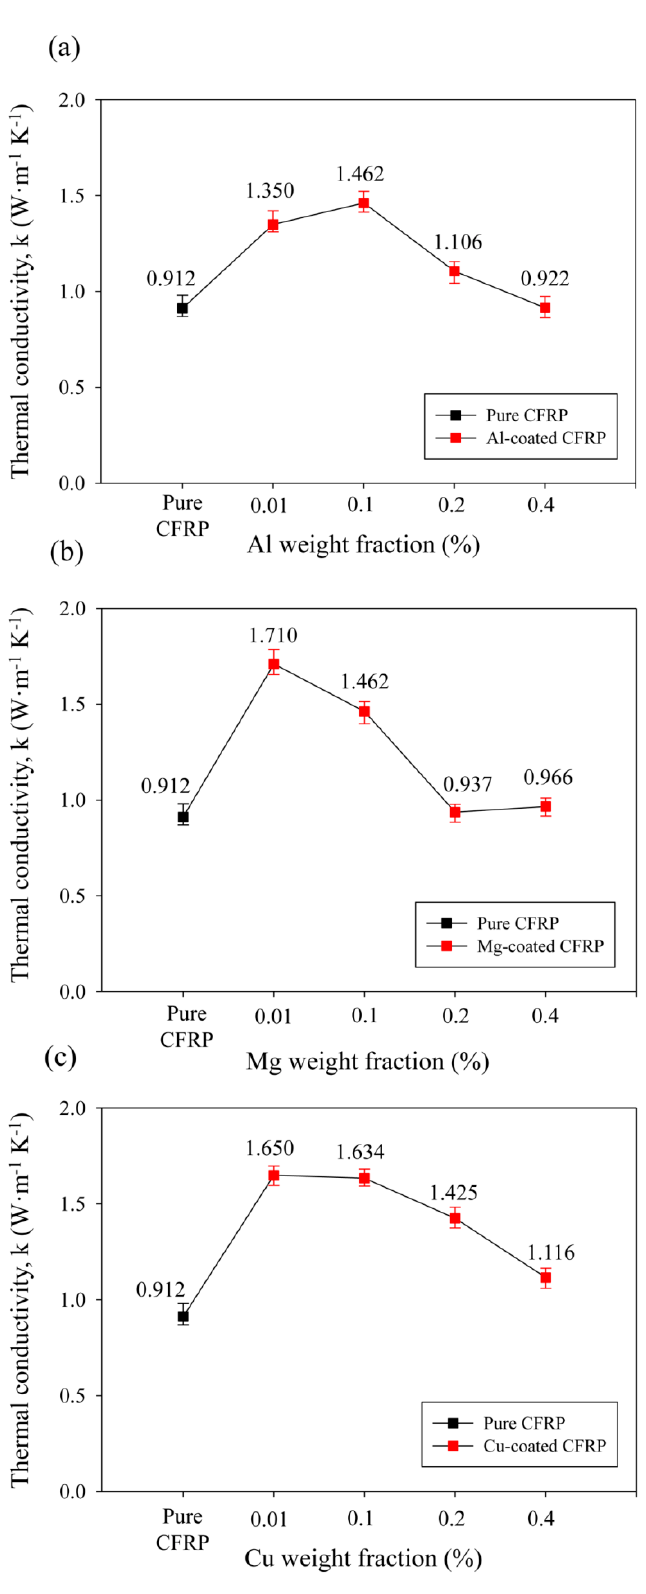
magnesium filler showed an 87% improvement in the thermal conductivity at 1.710 W m − 1 K − 1 and